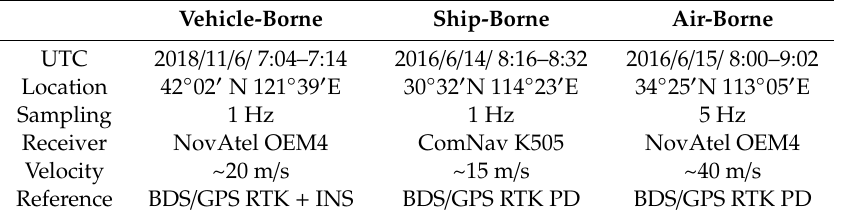
Table 2. Experimental description.